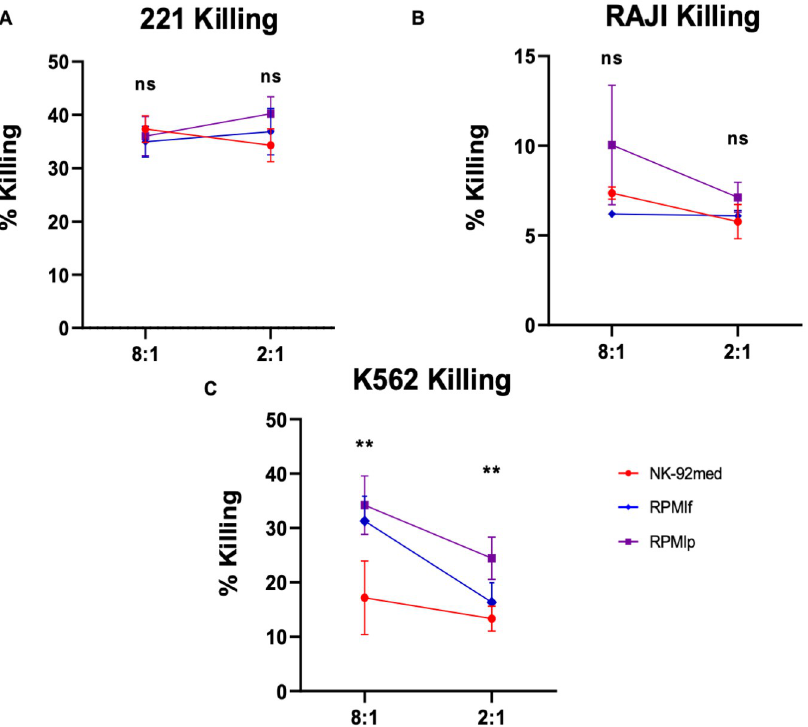
Fig 4. Comparison of killing potential. Killing of A) 721.221 cells, B) Raji cells, and C) K562 cells. E:Ts: 8:1, 2:1 red = NK-92med ., blue = RPMIf , violet = RPMIp . � p < 0.05, �� p < 0.005 compared between the NK-92 in NK-92 medium as control and the NK-92 in RPMI + IL-2 medium (two-tailed ANOVA test). Shown is 1 representative out of 5 killing assays